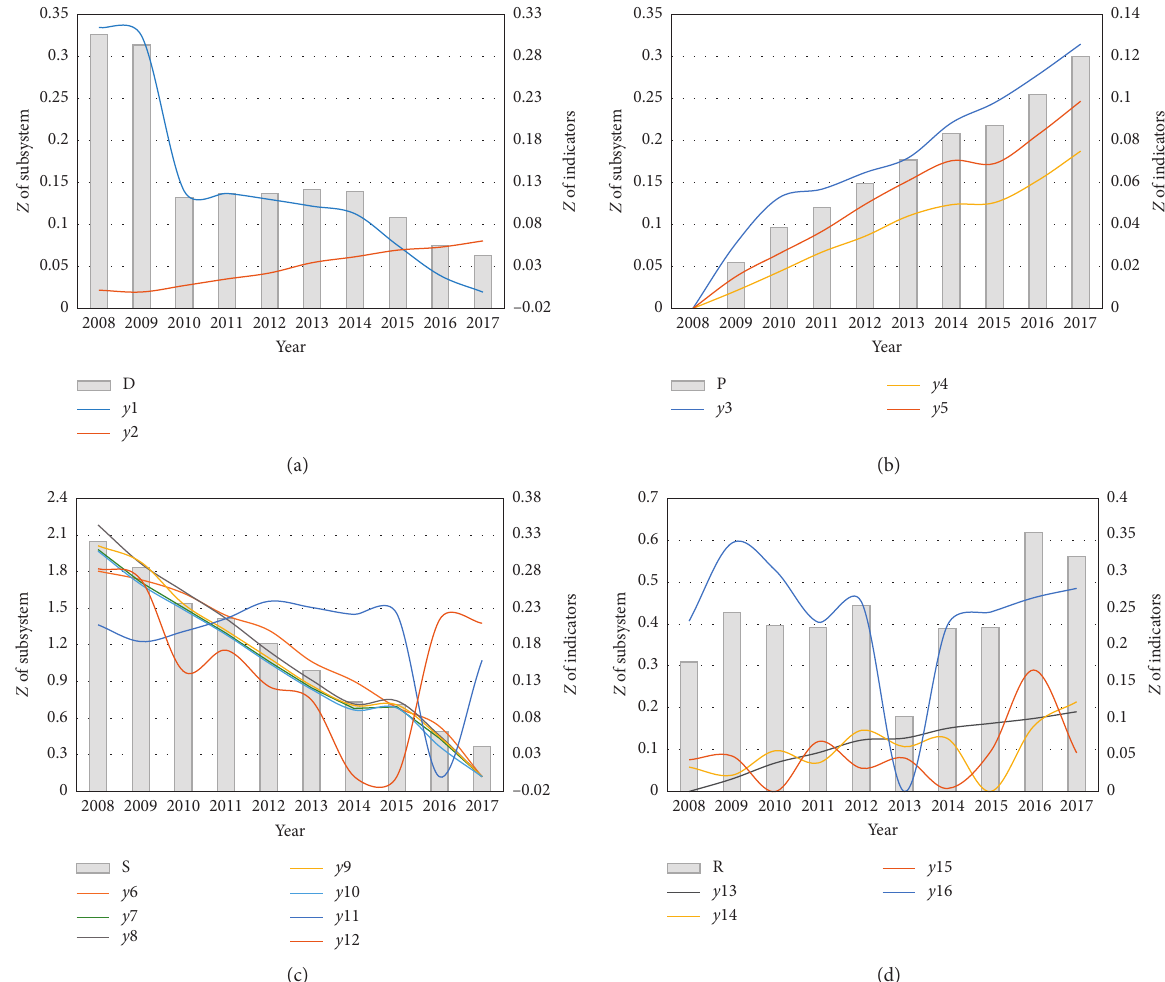
Figure 5: The projected characteristic value of subsystem and